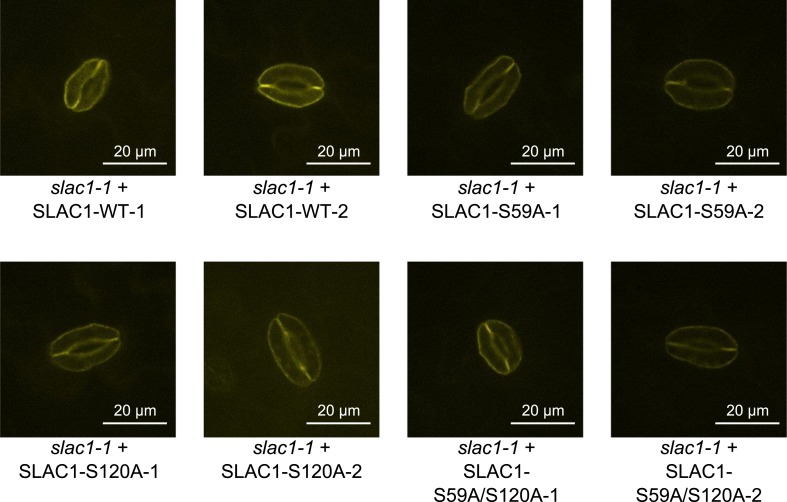
Analysis of expression and subcellular localization of SLAC1-WT, SLAC1S59A, S120A, and S59A/S120A in slac1-1 complementation lines.Confocal laser microscopy of guard cells of slac1-1 mutant lines expressing SLAC1-WT-mVenus, SLAC1S59A-mVenus, SLAC1-S120A-mVenus or SLAC1-S59A/S120A-mVenus shows membrane-localized expression of all SLAC1 versions. In addition intracellular YFP fluorescence was also observed in some guard cells, which may be linked to trafficking of SLAC1.